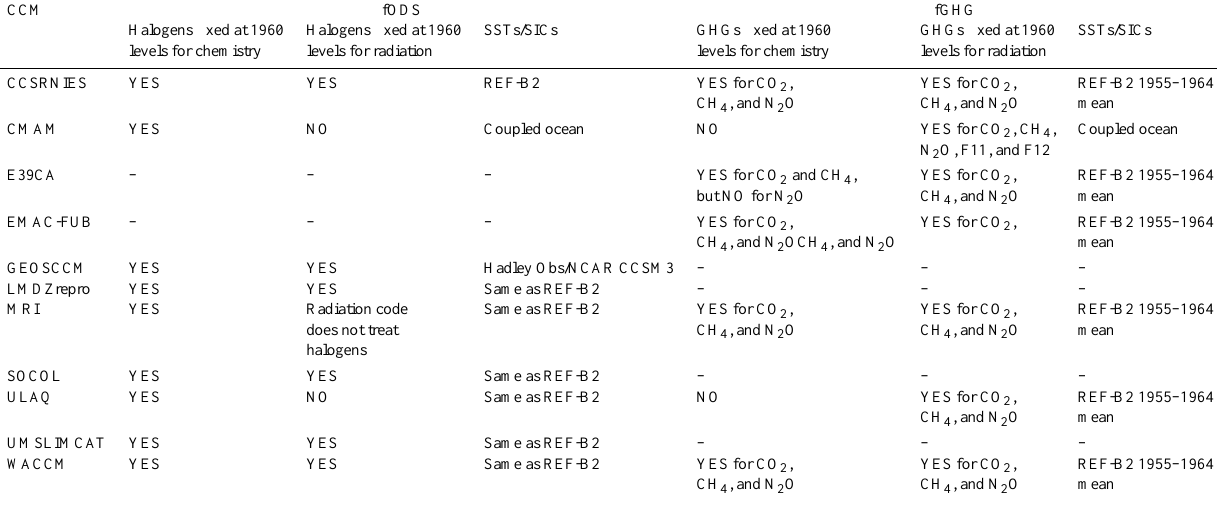
Table 2. Specifics of the sensitivity simulations with fixed ODSs (fODS) and fixed GHGs